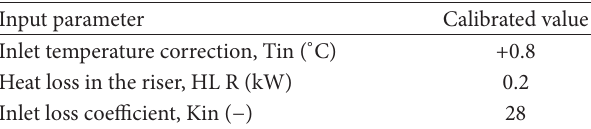
Table 4: Calibrated input parameters in the I-1, I-2 base cases. Input